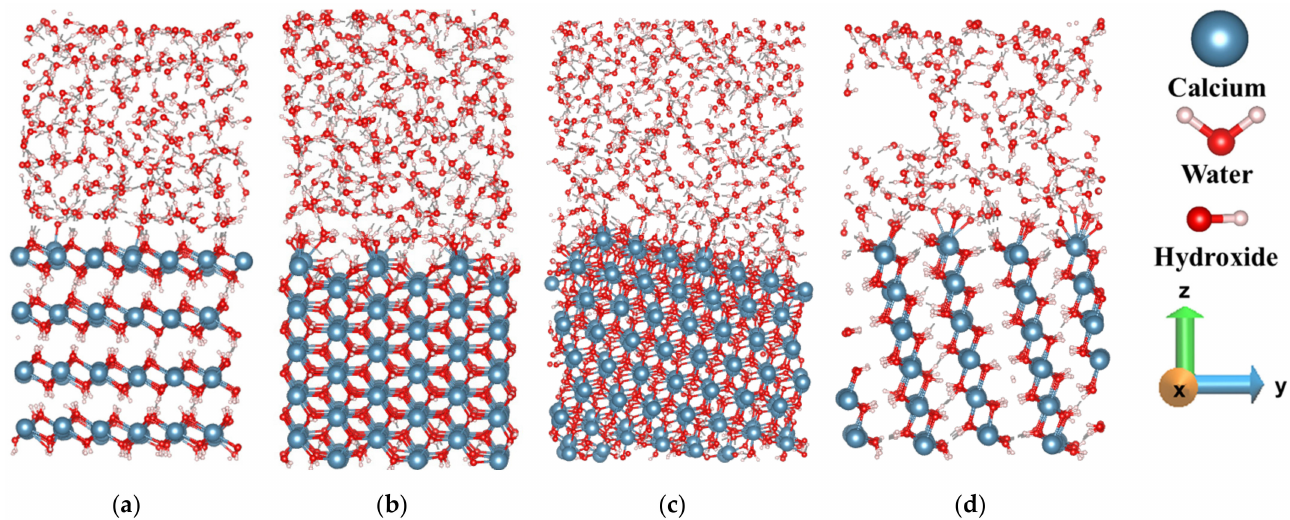
Figure 3. Comparison of the reactivity between the different facets of Portlandite: ( a ) (001), ( b ) (100), ( c ) (110), and ( d ) (010). Snapshots after pre-hydration simulations for 600 picoseconds at 298